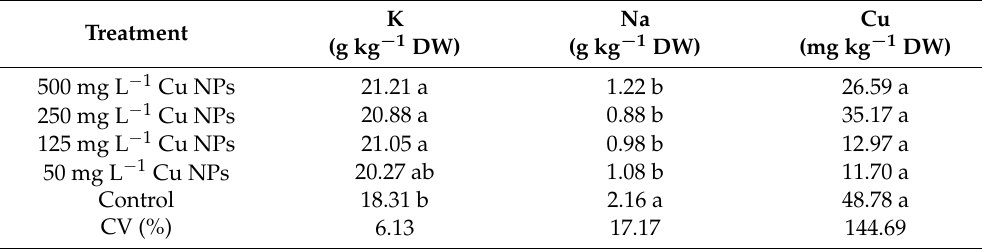
Table 1. The mineral content in tomato fruits with copper nanoparticles (Cu NPs) application.